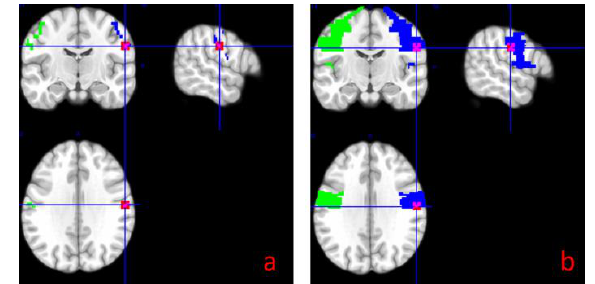
Fig. 5. (a) Cubic ROI centered in the MNI coordinates 58, -14, 32 (red/pink), and the Brodmann area 4 (left – green; right – blue). (b) Same ROI (red/pink) and precentral masks (left – green; right – blue).